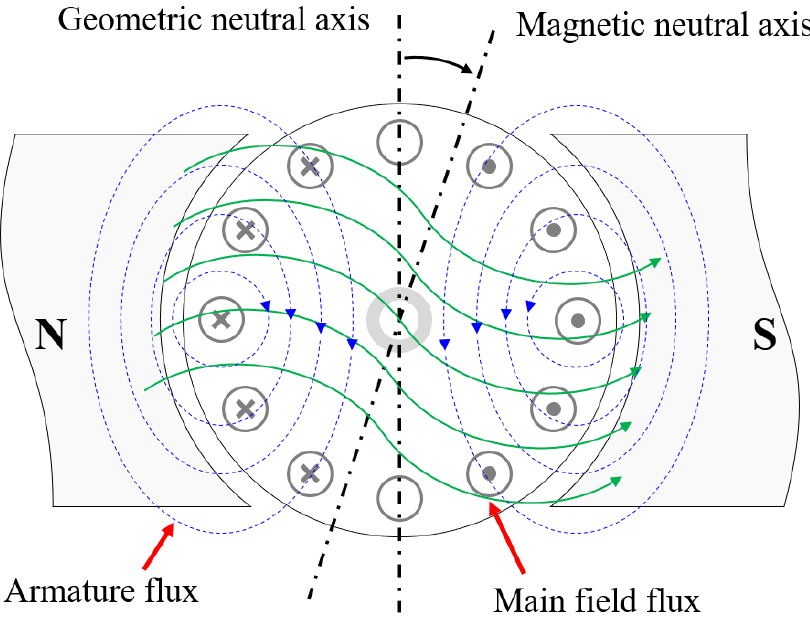
Figure 5. Distortion of main field flux due to armature